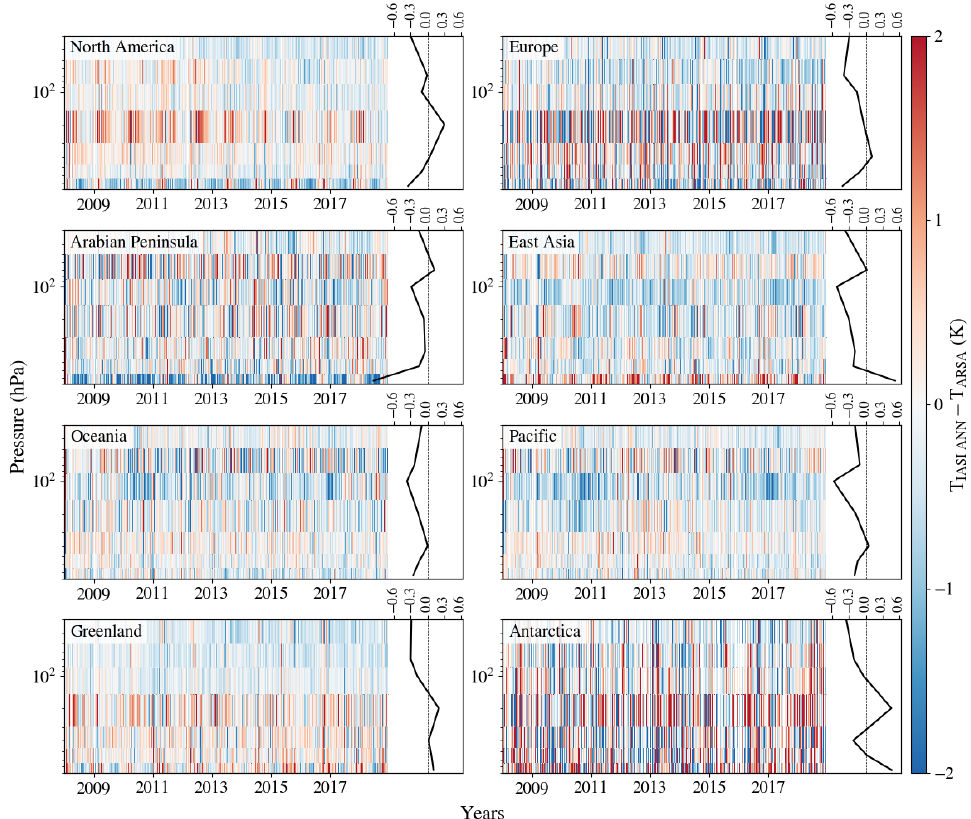
Figure 7. Daily differences between IASI-ANN and ARSA temperatures between 2008 and 2018 in North America, Europe, the Arabian Peninsula, East Asia, Oceania, the Pacific, Greenland, and Antarctica, with the time average difference profiles on the right of each subplot.